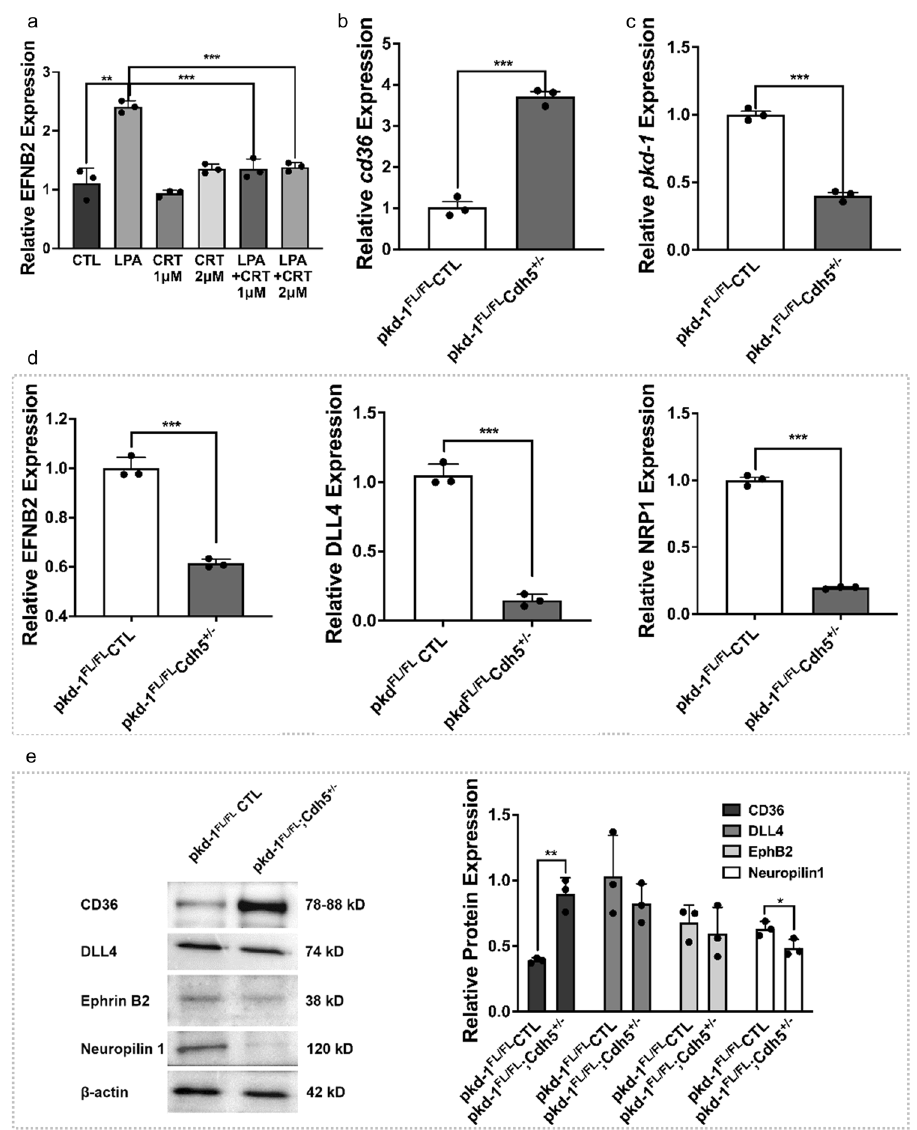
Fig. 3 Regulation of CD36 and arteriogenic gene expression via PKD-1 signaling in vascular endothelial cells. a HMVECi-D cells were cultured in an endothelial medium (DMEM medium with 5% MVGS and 5% FBS). After starvation in serum-free DMEM medium for 6 – 8h, the cells were treated with 10 µ M of LPA, and/or 1 or 2 µ M of CRT0066101 in serum-free DMEM medium for 24h under 5% CO 2 and 37°C. The total RNA was extracted and the mRNA levels of arterial gene ephrin B2 were detected by RT-qPCR. b Primary lung endothelial cells (ECs) were isolated from the control and EC-speci fi c pkd-1 knockout mice. Passage 1 ECs were used for extraction and puri fi cation of total RNA. mRNA levels of pkd-1 were detected by RT-qPCR and relative expression was compared between the control and pkd-1 -de fi cient ECs. c Increased expression of cd36 in pkd-1 -de fi cient lung ECs. Lung ECs were isolated from the control and EC-speci fi c pkd-1 knockout mice. Passage 1 lung ECs were used for extraction and puri fi cation of total RNA. mRNA levels were detected by qPCR and relative expression was compared between ECs from the control and EC-speci fi c pkd-1 knockout mice. d Decreased expression of arteriogenic genes in pkd-1 -de fi cient lung ECs. Primary lung ECs were isolated from the control and EC-speci fi c pkd-1 knockout mice. Passage 1 ECs were used for extraction and puri fi cation of total RNA. mRNA levels were detected by RT-qPCR and relative expression was compared between the control and pkd-1 -de fi cient ECs. e The cell lysate was extracted from passage 1 primary lung ECs that were isolated from EC-speci fi c PKD-1 and control mice for detection of protein expression by Western blotting. Triplicate experiments were performed and levels of protein expression assessed by densitometry with Image J. * P <0.05, ** P <0.01, or *** P <0.001 vs.